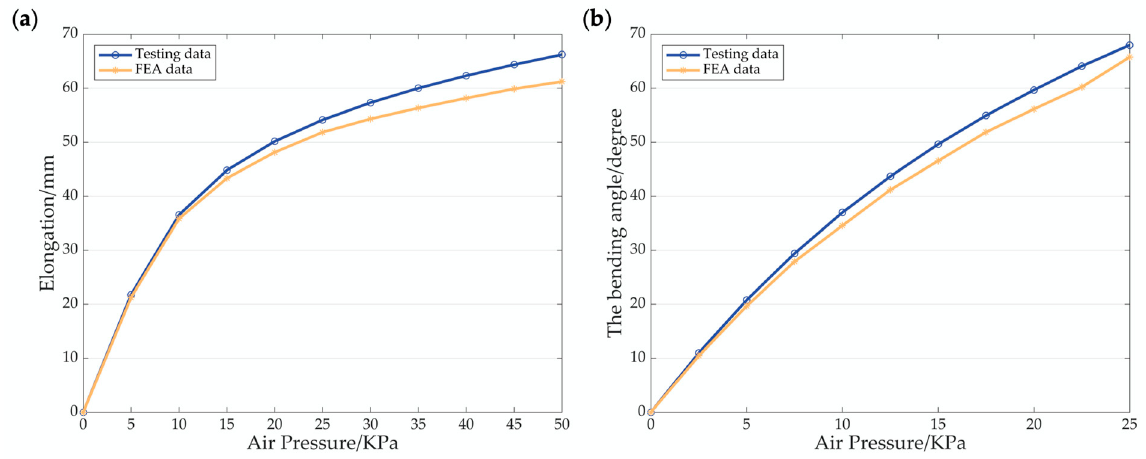
Figure 18. Comparison of the FEA data and the testing data. ( a ) Elongation of the single-channeled actuator. ( b ) Bending angle of the double-channeled actuator.